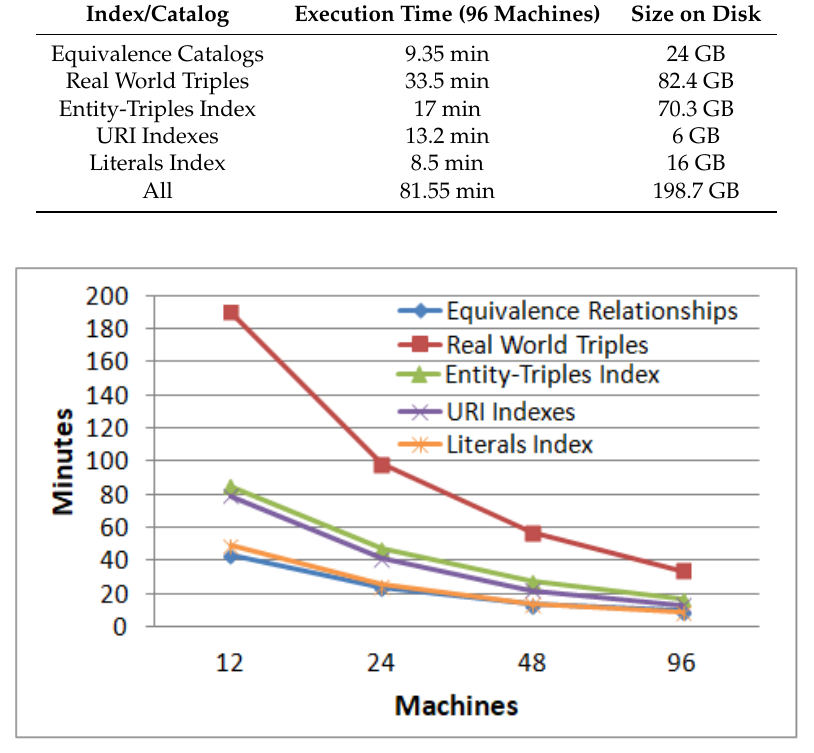
Figure 3. Creation time of indexes and catalogs for different number of